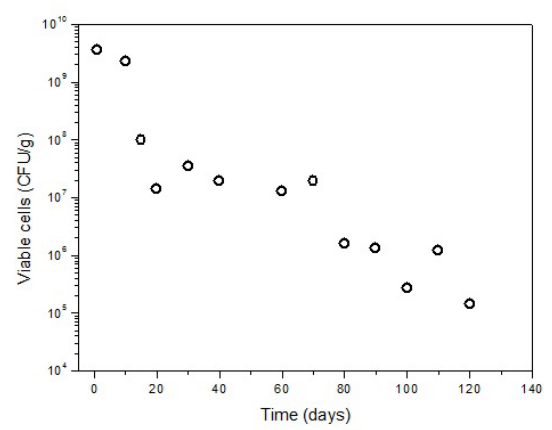
Figure 6 - Concentration of viable cells of Lact . rhamnosus in alginate capsules covered with gelatin for 120 days of storage at 8 o C.